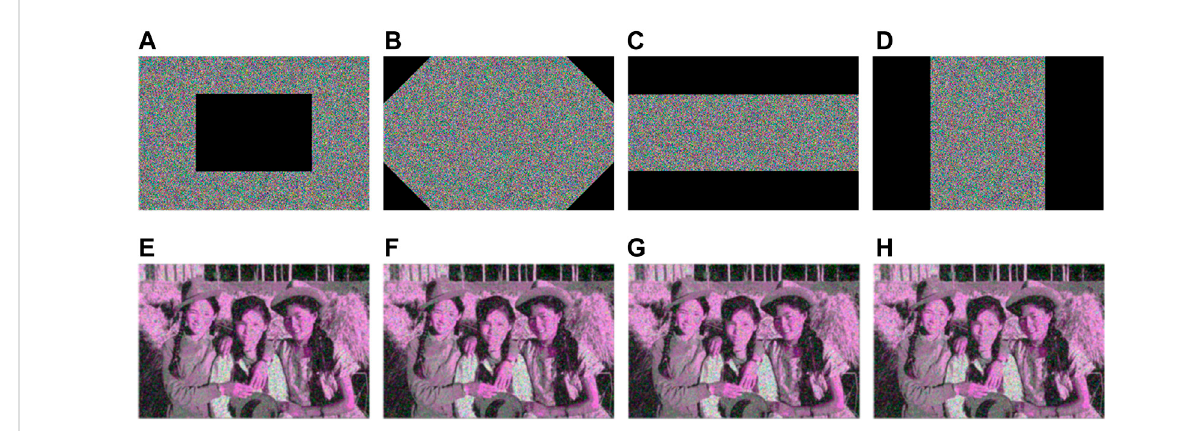
FIGURE 18 Sheared images in different position: (A – D) , the corresponding decryption images: (E – H) .